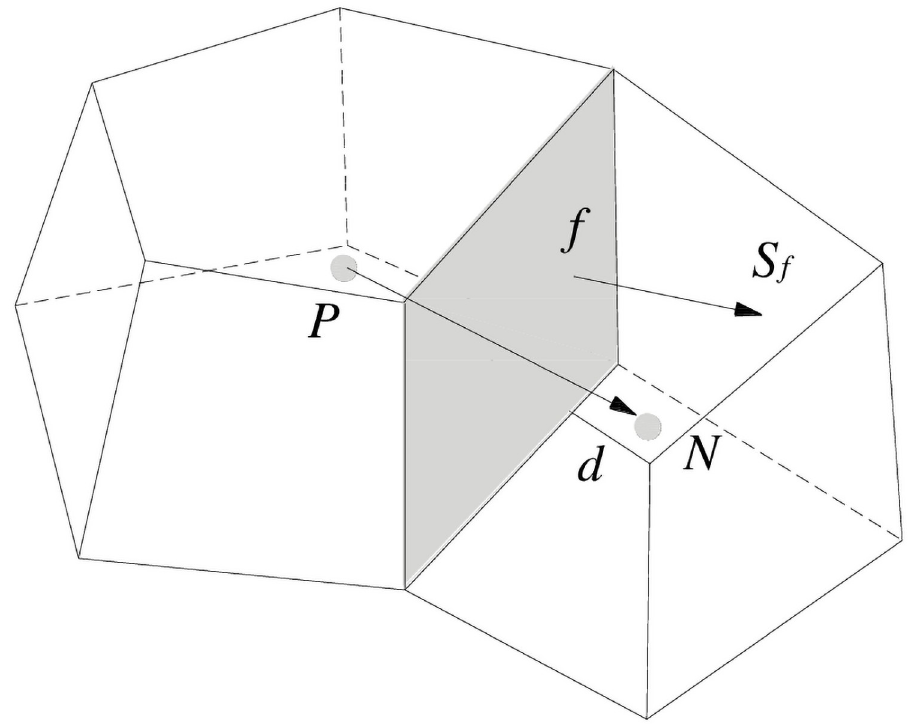
Fig 2. Parameters used in the finite volume discretization